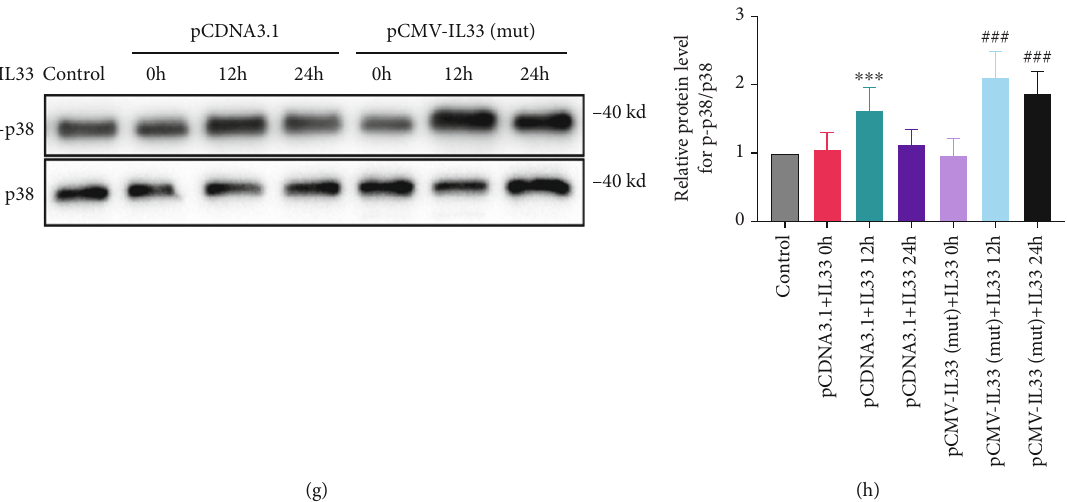
Figure 5: rs10975519 mutation on IL-33 gene contributed to EMT in HK2 cells via activating p38 MAPK signaling pathway. (a) Representative WB results showed rs10975519 mutation of IL-33 gene promoted the expression of EMT-related markers including FN, E-cadherin, and α -SMA. (b) Semiquantitative analysis results of relative protein abundances of FN, E-cadherin, α -SMA, and IL-33 were shown in each group. Values represented the mean ± SD ( n = 3 ; ∗ P < 0 : 05 and ∗∗∗ P < 0 : 001 compared with the pCDNA3.1 group). (c) Representative WB results showed that activation in Erk1/2, p38, and the c-Jun MAPK signaling pathways in HK2 cells transfected with pCDNA3.1 and IL-33. (d) Semiquantitative analysis results of relative protein abundances of p-Erk1/2, Erk1/2, p-p38, p38, p-c-Jun MAPK, and the c-Jun MAPK were shown in each group. Values represented the mean ± SD ( n = 3 ; ∗∗ P < 0 : 01 and ∗∗∗ P < 0 : 001 compared with the control group). (e) Representative WB results showed that activation of p38 MAPK pathway was involved in IL-33- induced EMT in HK2 cells with pCDNA3.1 transfection. (f) Semiquantitative analysis results of relative protein abundances of p-p38, p38, FN, E-cadherin, and α -SMA were shown in each group. Values represented the mean ± SD ( n = 3 ; ∗ P < 0 : 05 , ∗∗ P < 0 : 01 , and ∗∗∗ P < 0 : 001 compared with the pCDNA3.1 group; # P < 0 : 05 and ### P < 0 : 001 compared with the pCMV-IL-33(mut) group). (g) Representative WB results showed that phosphorylated p38 MAPK level increases continually in rs10975519 mutant comparing with the pCDNA3.1 group, suggesting rs10975519 mutant of IL-33 gene could continuously activate p38 MAPK pathway. (h) Semiquantitative analysis results of relative protein abundances of p-p38 and p38 were shown in each group. Values represented the mean ± SD ( n = 3 ; ∗∗∗ P < 0 : 001 compared with the pCDNA3.1+IL-33 group; ### P < 0 : 001 compared with the pCMV-IL-33(mut)+IL-33 group). Abbreviations: EMT: epithelial-mesenchymal transition; MAPK: mitogen-activated protein kinase; FN: fi bronectin; α -SMA: alpha smooth muscle actin; WB: western